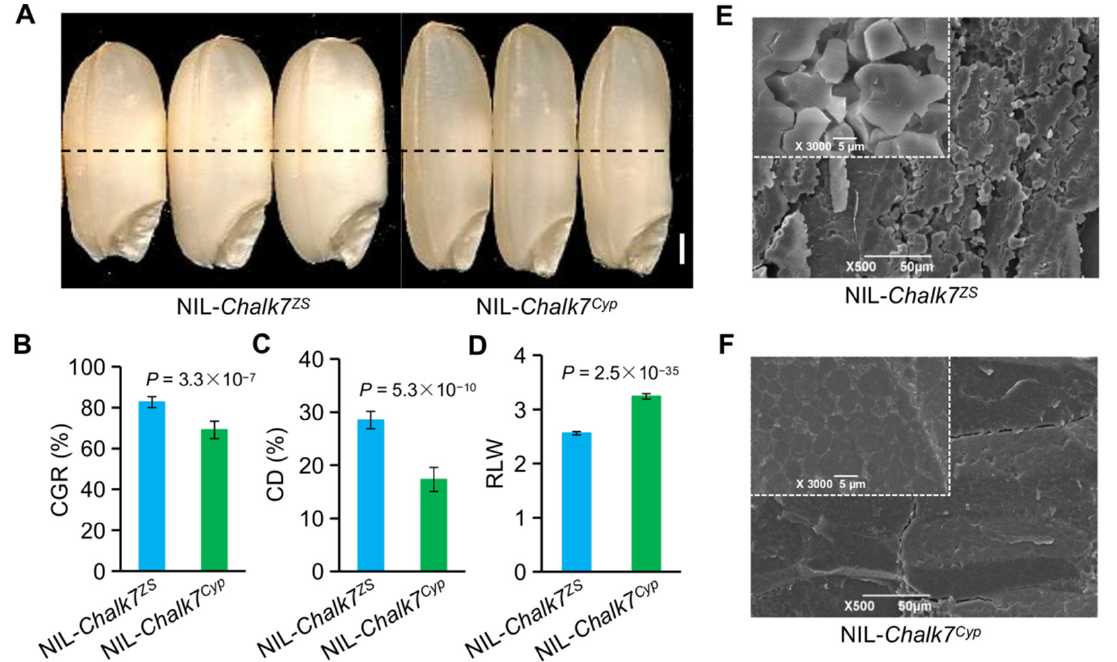
Figure 1. Chalk7 confers grain chalkiness in rice. ( A ) Grains of NIL- Chalk7 ZS and NIL- Chalk7 Cyp . Scale bar, 1 mm. ( B – D ) Differences of NIL- Chalk7 ZS and NIL- Chalk7 Cyp in chalky grain rate (CGR), chalkiness degree (CD), and the ratio of grain length to width (RLW). Data are given as the mean and SE (n = 20). Student’s t- test was used to generate p values. ( E , F ) Scanning electron microscopy images showing starch granule structure of the endosperm of NIL- Chalk7 ZS ( E ) and NIL- Chalk7 Cyp ( F ). The observed section is indicated as the dashed middle bellies of the endosperm in ( A ).